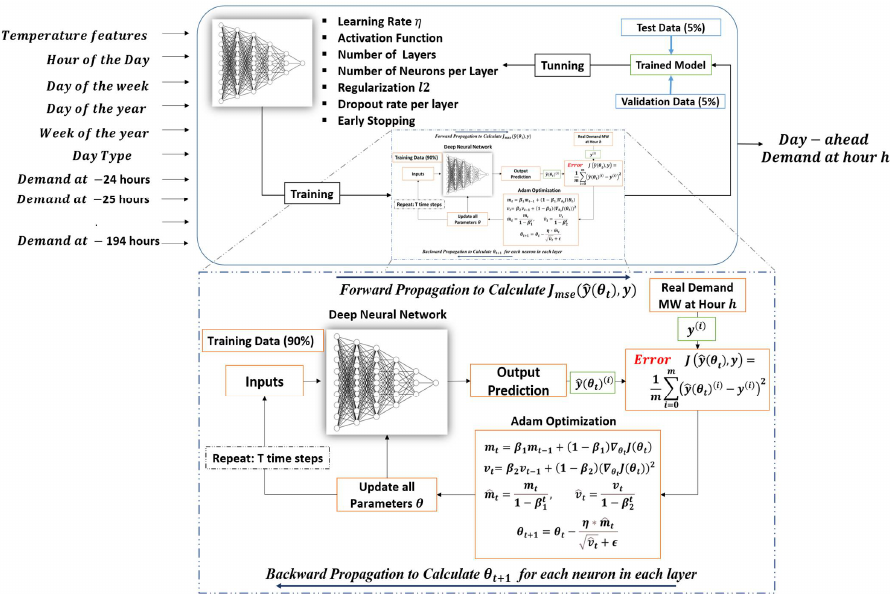
Figure 8. Day-ahead deep learning model for demand prediction at hour h.